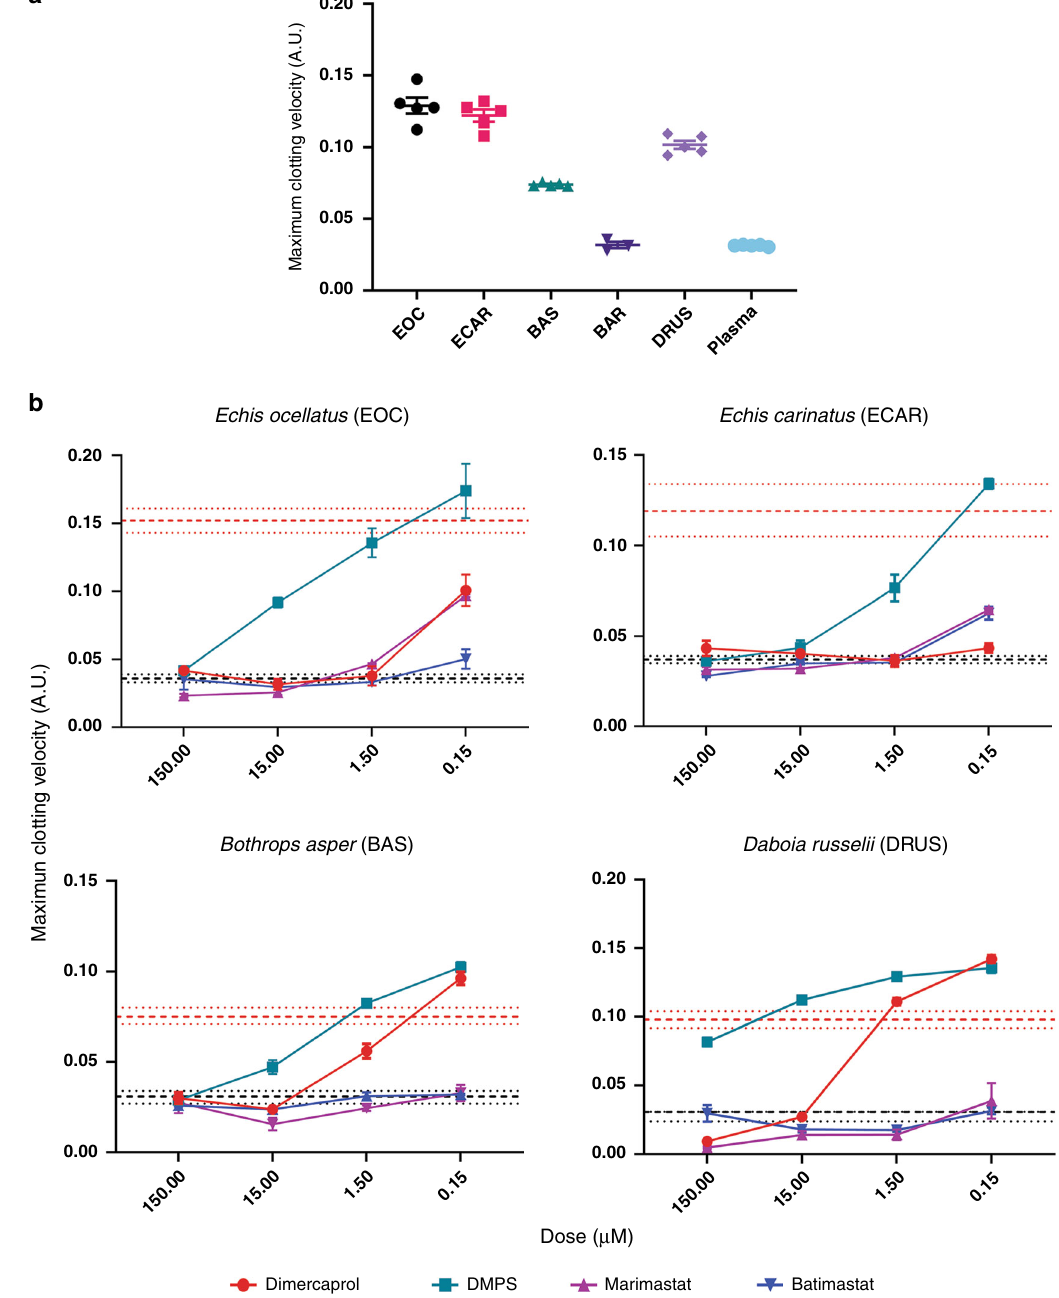
Fig. 3 SVMP-inhibitors neutralize the in vitro procoagulant activities of several geographically distinct viper venoms. a The coagulopathic activities of the viper venoms, showing that all, except B. arietans (BAR), exhibit procoagulant effects by increasing the clotting velocity in comparison with the normal plasma control. The data presented represents the maximum clotting velocity, calculated as the maximum of the fi rst derivative of each clotting curve, from triplicate independent repeat experiments with SEMs, where each technical repeat represents the mean of n ≥ 2 technical replicates. EOC E. ocellatus ; ECAR E. carinatus ; BAS Bothrops asper ; BAR, Bitis arietans ; DRUS, Daboia russelii . b Neutralization of procoagulant venom activity by four SVMP-inhibitors across four drug concentrations (150 µ M to 150 nM). The data is expressed as the maximum clotting velocity at each dose. The negative (PBS) and positive (venom-only) controls are presented as intervals (dashed black and red lines, respectively), with the latter representing the mean maximum clotting velocity in these samples ± SEM. Inhibitors are color-coded (dimercaprol, red; DMPS, turquoise; marimastat, purple; batimastat, blue). The data represent triplicate independent repeats with SEMs, where each technical repeat represents the mean of n ≥ 2 technical replicates. Note the different y-axis scales. Source data provided in Supplementary Data